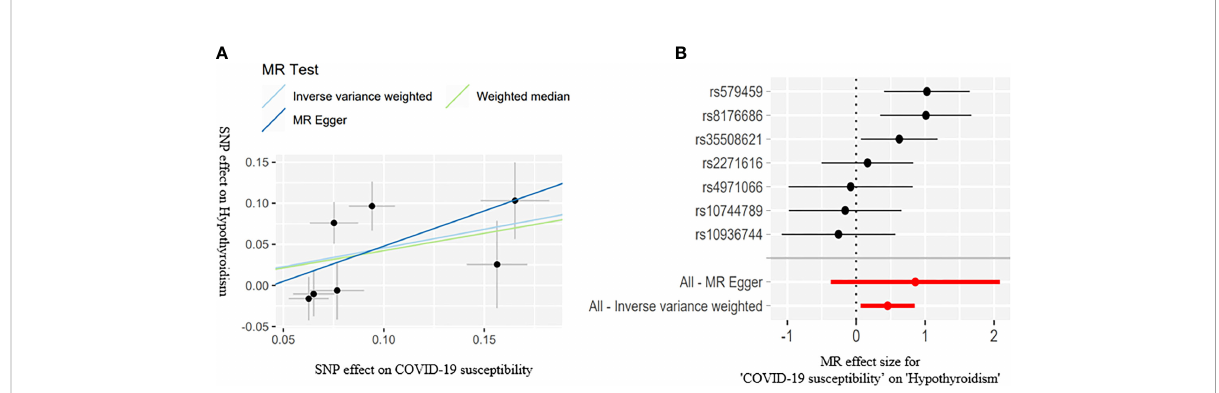
FIGURE 2 Scatter plots (A) for estimating causal effects of genetically predicted susceptibility on risk of hypothyroidism. Each black point representing the effect sizes of each SNP on the exposure (horizontal axis) and on the outcome (vertical axis) is plotted with error bars corresponding to each standard error (SE). The slope of each line corresponds to the combined estimate using each method of the IVW (light blue line), the MR-Egger regression (blue line), and the weighted median (light green line). Forest plots (B) of susceptibility on the risk of hypothyroidism; the red points showed the combined causal estimate using all SNPs together in a single instrument, using two different methods (MR-Egger and